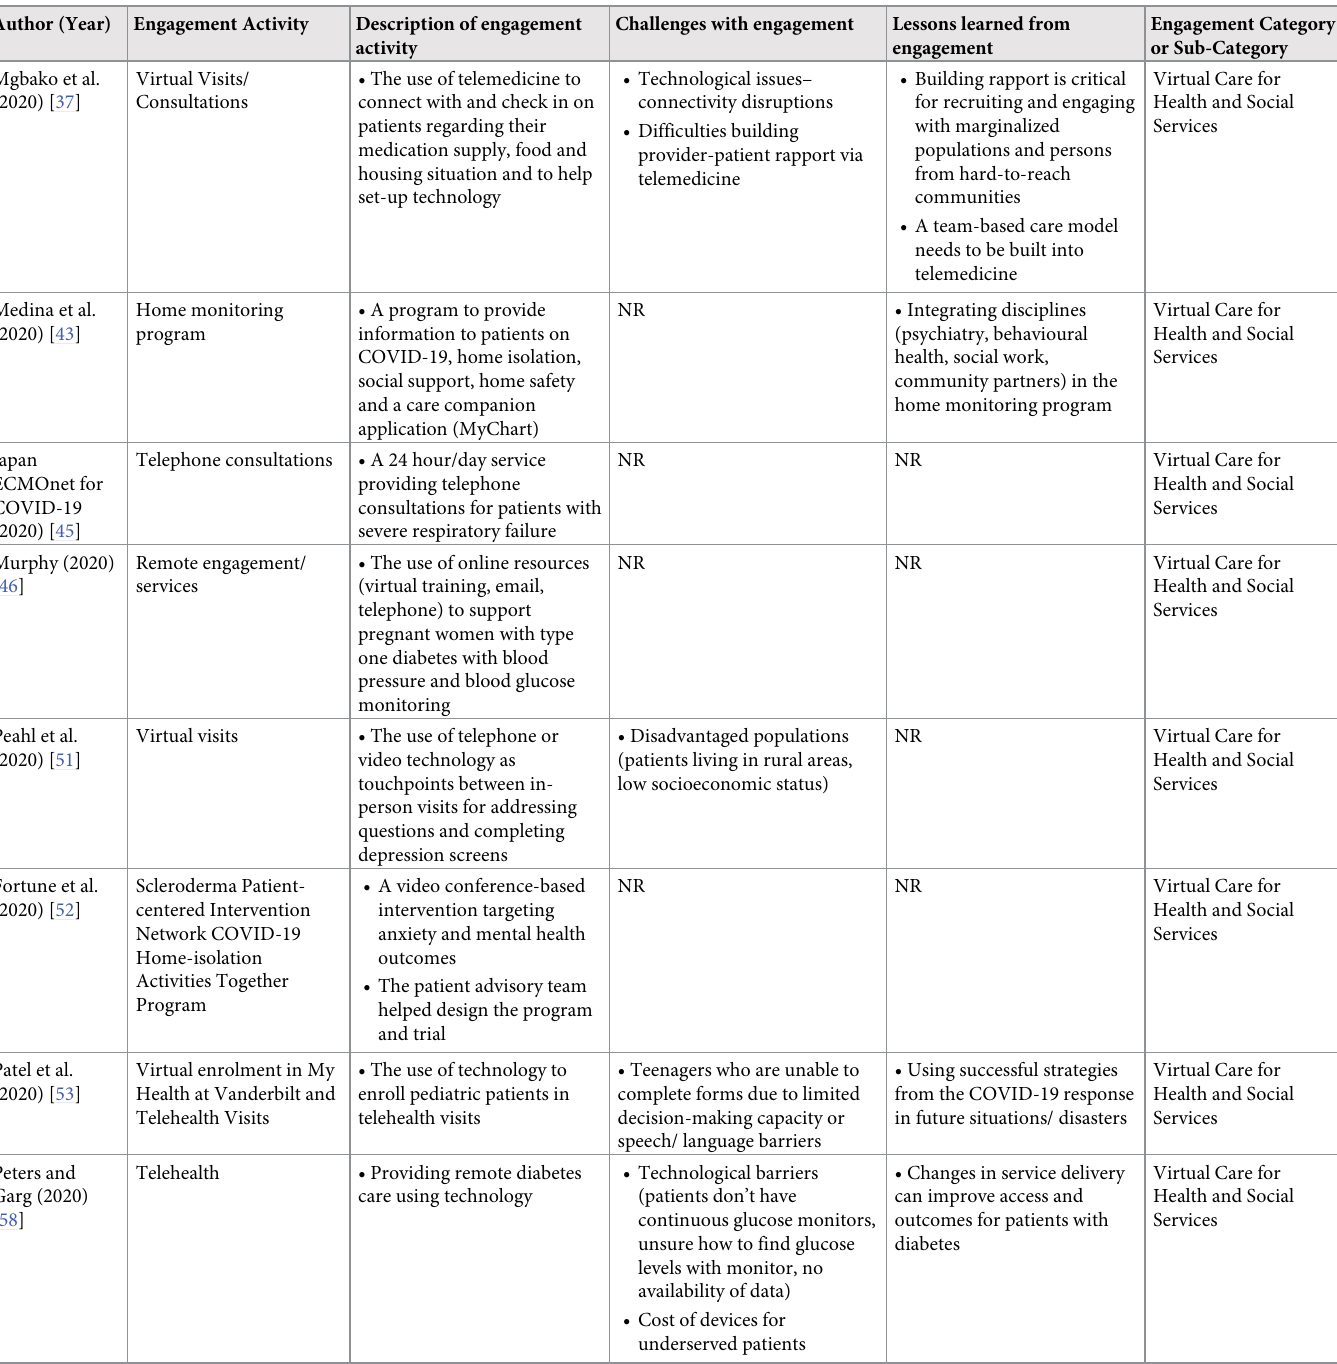
Table 2. Characteristics of patient engagement